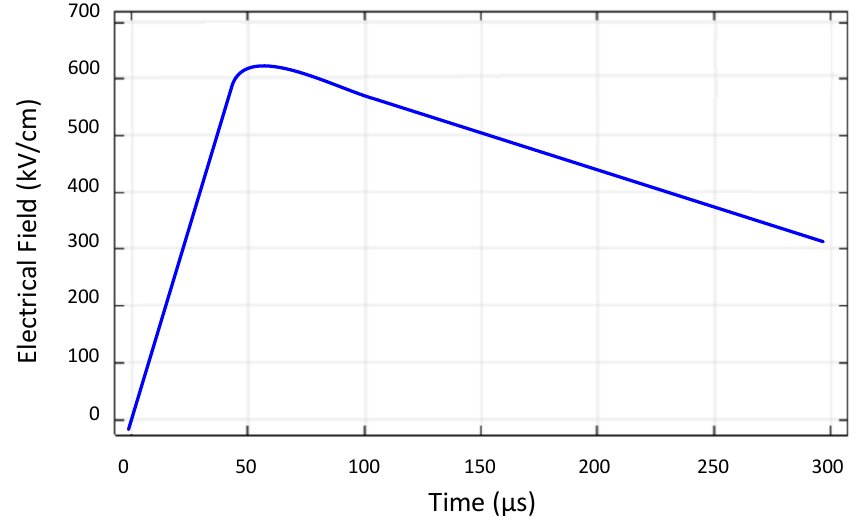
Figure 8. Electrical field on the standard LPS blade.